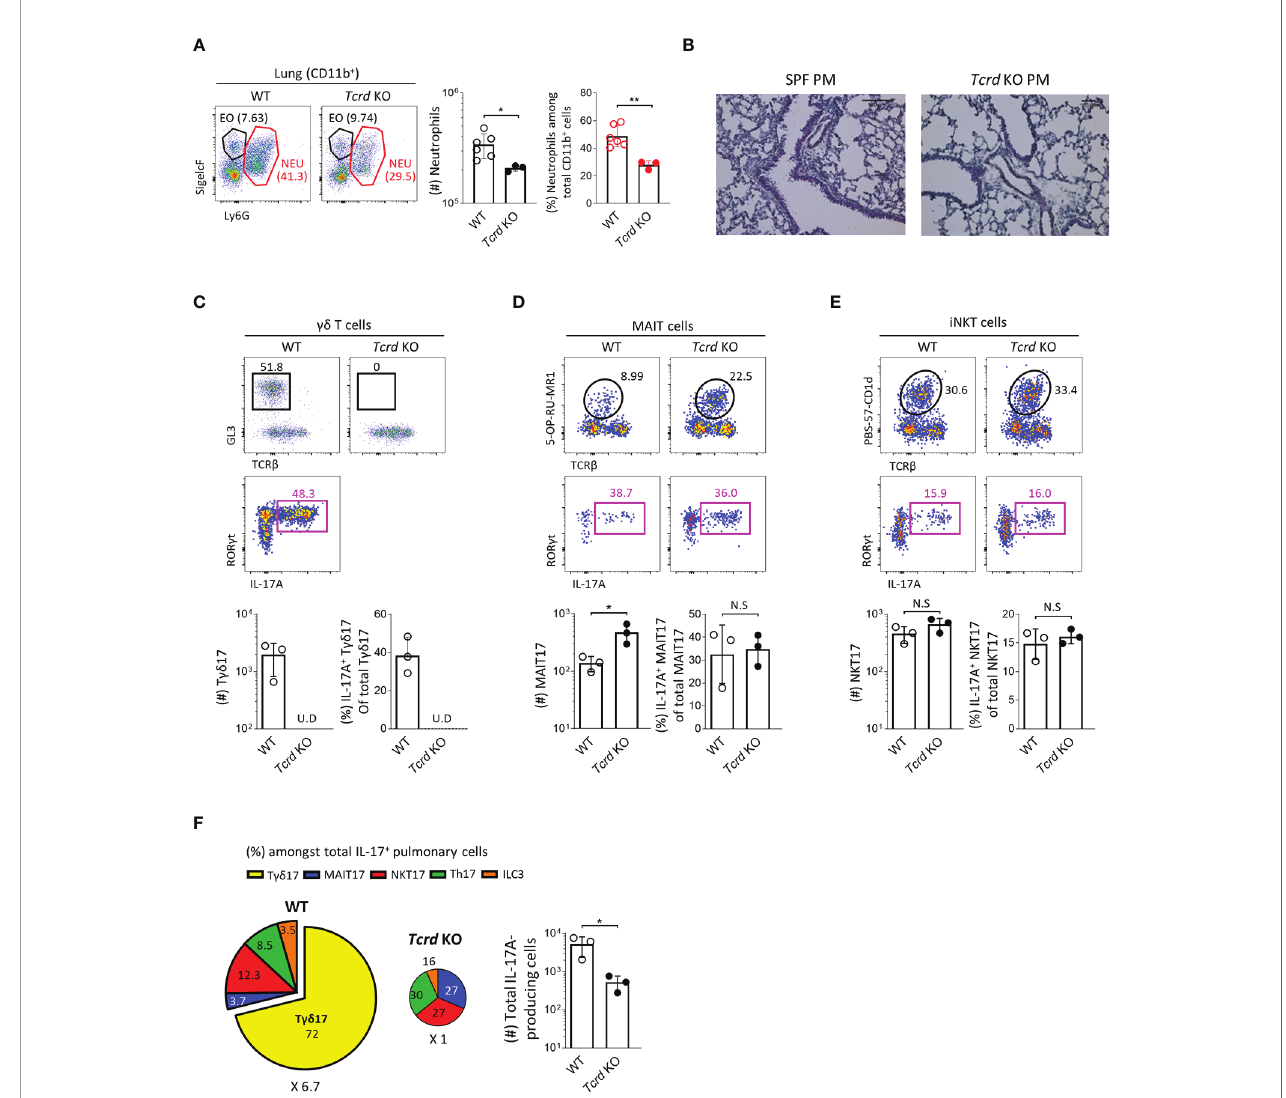
FIGURE 7 | T gd 17 cells promote PM-induced acute pulmonary neutrophilic in fl ammation. (A, C – F) B6 WT and Tcrd KO mice were intranasally (i.n.) administered with 250 m g of PM and single cell suspensions of lung tissue were analyzed at 24 hours after PM exposure. (A) Representative dot plots are shown after gating CD11b + cells. Bar graph shows statistical analysis of absolute numbers of neutrophils and their frequencies among total CD11b + cells. (B) Mice were (i.n.) administered with 250 m g of and analyzed at 12 hours after PM exposure. Representative hematoxylin-eosin (H&E) stained lung sections are shown (original magni fi cation X200). (C – E) Representative dot plots show total gd T (C) , MAIT (D) and NKT (E) cells (upper panels) in WT and Tcrd KO mice and their IL-17A production (lower panels). Bar graphs show statistical analysis of absolute numbers and frequencies of each IL-17-producing innate T cells. (F) Pie charts show mean frequencies (proportional to angle) and numbers (proportional to area) of indicated cells among total IL-17A-producing pulmonary cells. Bar graphs show statistical analysis of absolute numbers of total IL-17-producing cells. Numbers indicate frequencies of cells in adjacent gates (A, C – E) or area (F) . Each dot represents an individual mouse and error bars indicate ± SD. U.D, undetected. Unpaired two-tailed t -test was used. N.S, not signi fi cant, *P < 0.05, **P < 0.01. EO, eosinophil; NEU,